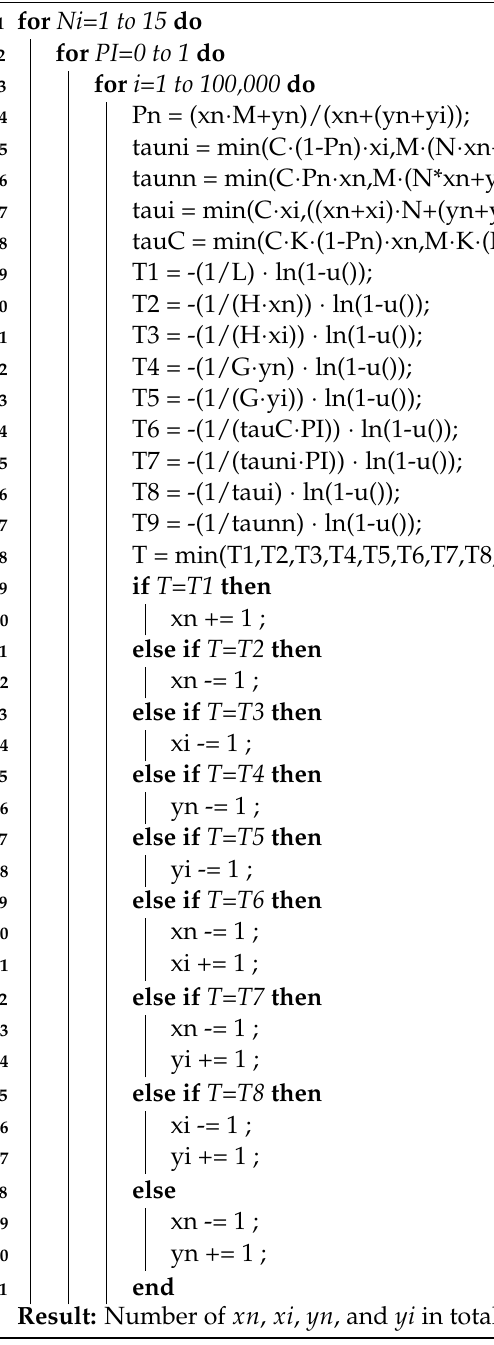
Algorithm A3: Chain adding a parameter as a